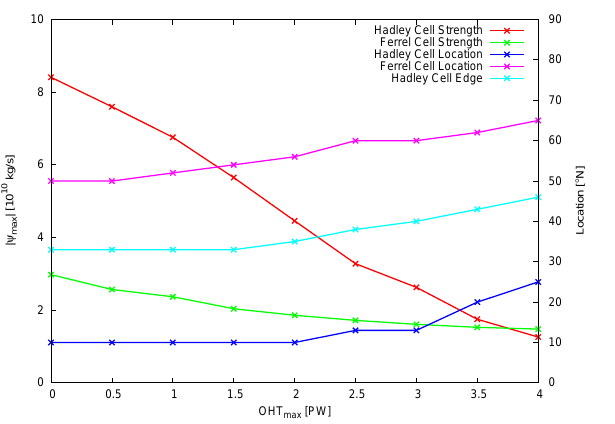
respective component for the transport in the reference state